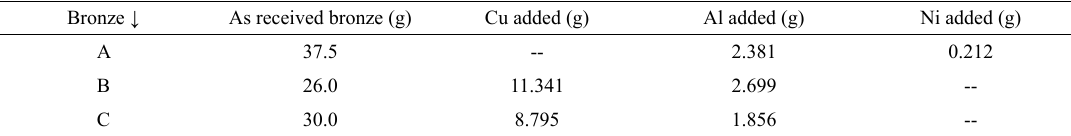
Table 2. Correction for the compositional aluminum bronzes A, B and C with a total mass of 40 g and the Cu-13.0Al-4.0Ni SMA.